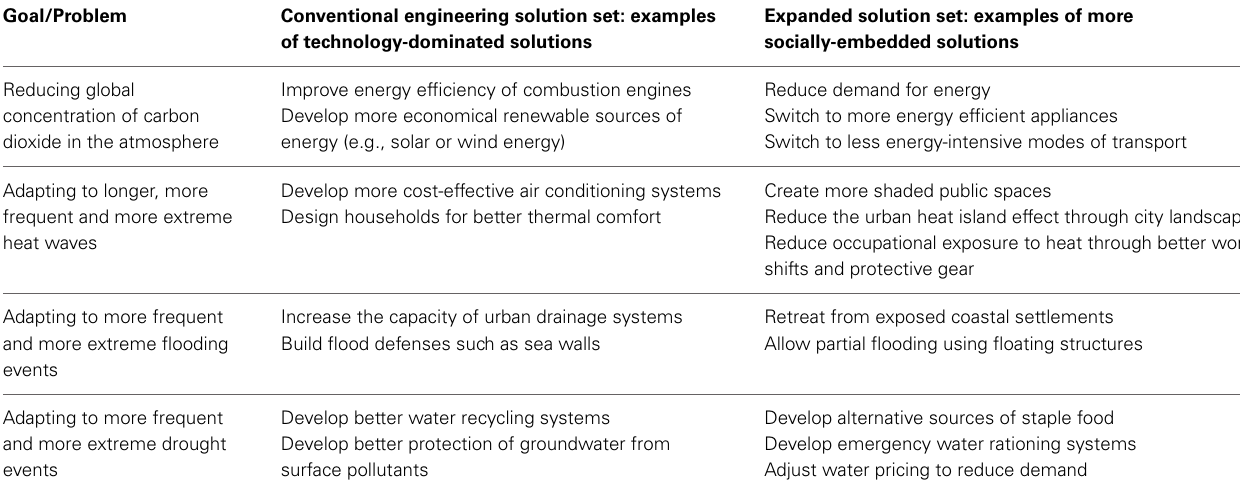
Table 2 | Expanded solution set through inclusion of socially-embedded